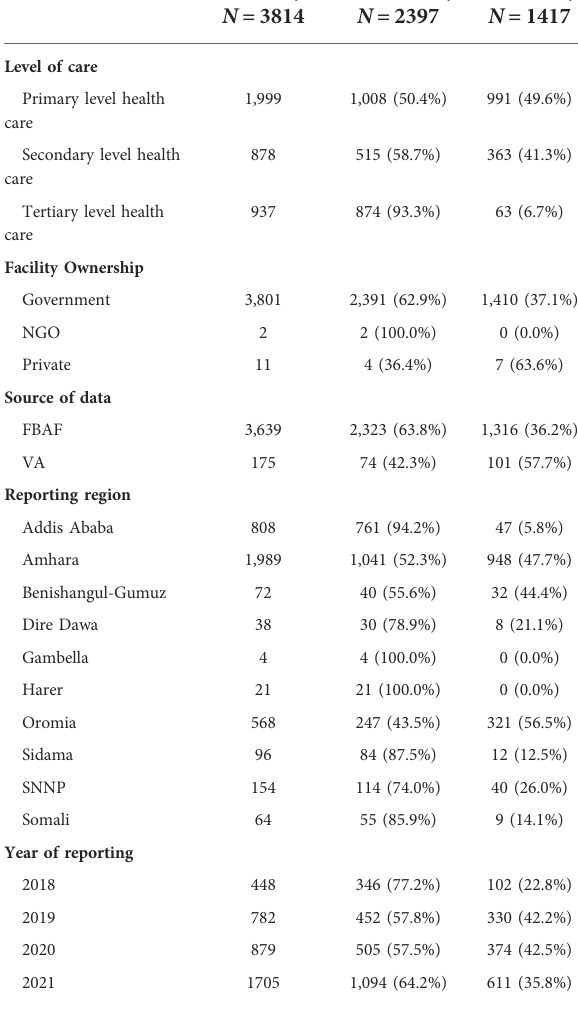
TABLE 2 Selected background characteristics of reporting facilities by outcome status of the perinate in